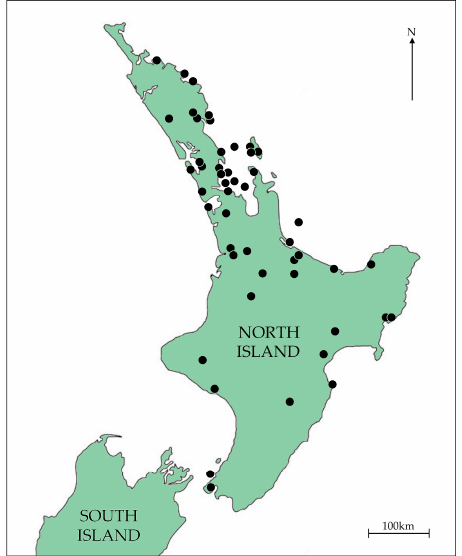
Figure 1. Ecological restoration projects with community participation considered in this study (North Island, New Zealand).